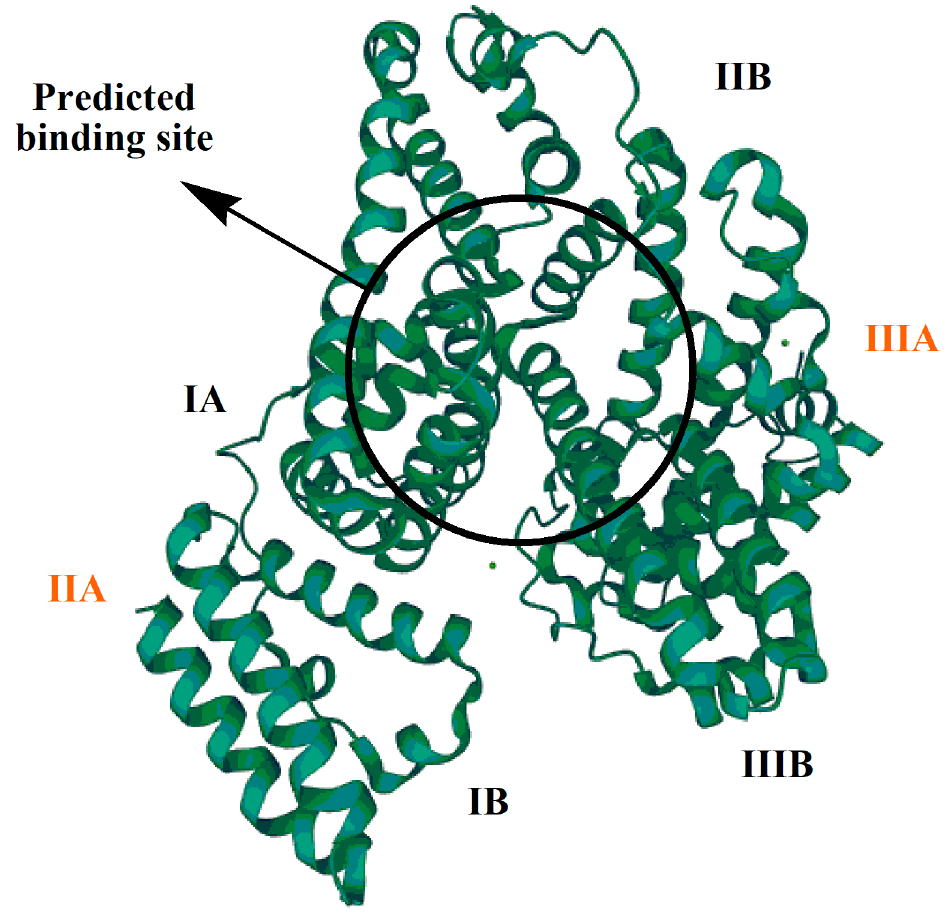
Figure 1. Bovine serum albumin (BSA).